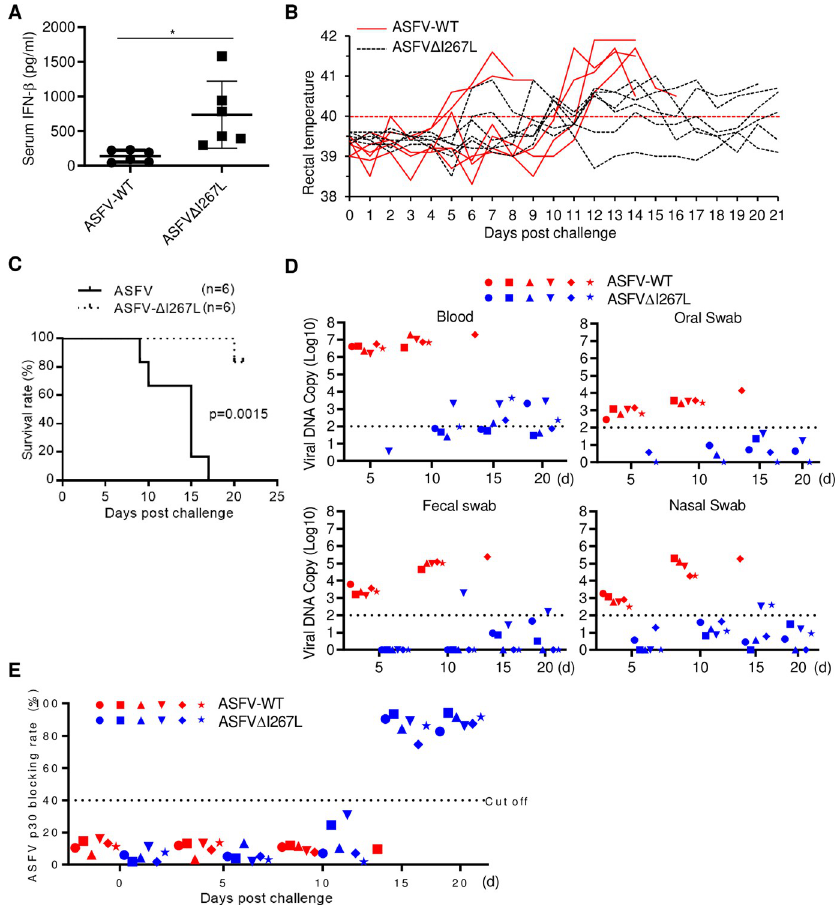
Fig 7. Deficiency of I267L attenuates virulence and pathogenesis of ASFV. ( A , B , C , D and E ) Pigs were inoculated intramuscularly (i.m.) with either 10 HAD 50 of ASFV Δ I267L (n = 6) or ASFV-WT (n = 6). The pigs were monitored daily for 21 days for temperature and mortality. The expression level of IFN- β in serum at 5 days post challenge were determined by ELISA (A), the daily temperature changes of pigs were shown in panel (B), the survival rates were shown in panel (C), viral DNA copies in blood, oral swab, fecal swab, and nasal swab collected at 5, 10, 15, and 20 days post challenge were determined by qPCR and shown in panel (D), and the antibodies angaist p30 were determined using an in-house blocking ELISA